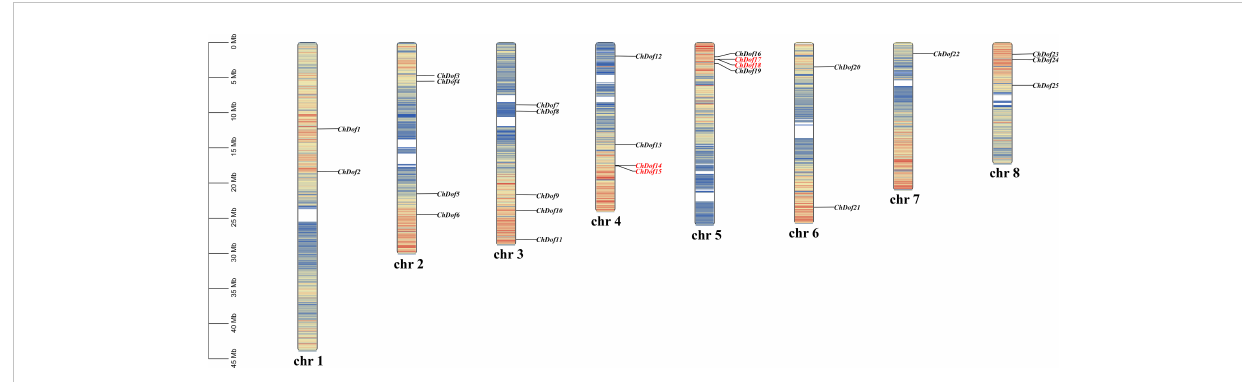
FIGURE 4 Chromosome location of ChDof genes. All 25 ChDof genes are shown on the chromosomes and indicated by their names. The left scale represents the length of the C. humilis chromosomes. Chromosome numbers are presented at the bottom of each bar. Tandemly duplicated gene pairs are indicated with